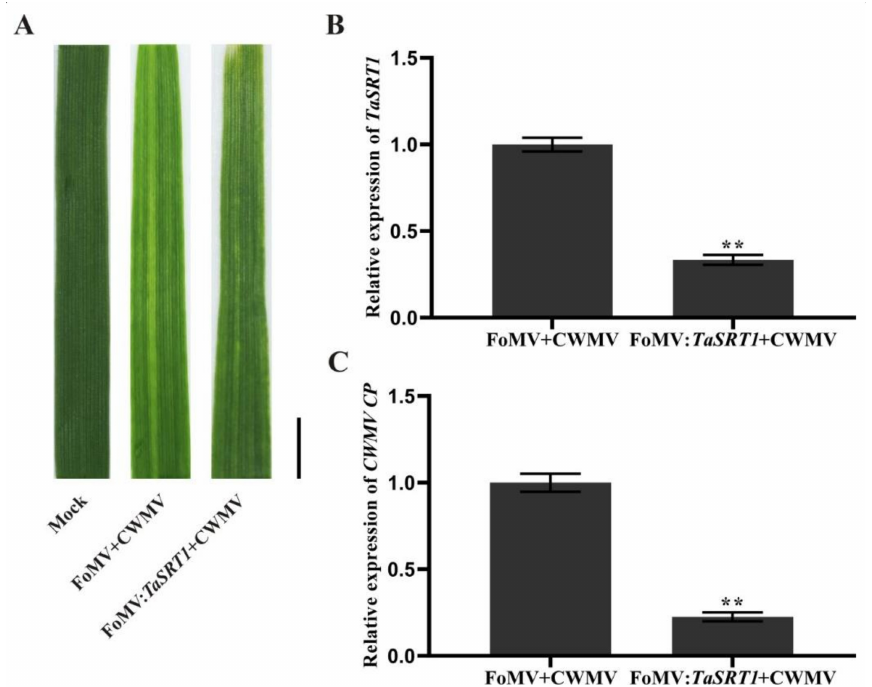
Figure 9. Silencing TaSRT1 by Foxtail mosaic virus (FoMV)-based virus-induced gene silencing (VIGS) significantly alleviated Chinese wheat mosaic virus (CWMV) infection in Triticum aestivum . ( A ) Phenotypes in newly formed leaves of the plants inoculated with phosphate buffer saline (PBS) as Mock, FoMV + CWMV, FoMV: TaSRT1 + CWMV, respectively. Photographs were taken at 14 d post-inoculation (dpi) with viruses. Bar = 1 cm. ( B ) Relative expression level of TaSRT1 was analyzed with FoMV: TaSRT1 + CWMV infected wheat plants by RT-qPCR. Total RNA from a FoMV + CWMV infected wheat plants was isolated used as a control. ( C ) Relative expression level of CWMV CP was analyzed in leaf 4 from TaSRT1 -silenced or non-silenced wheat plants. Each experiment was performed using three biological and each biological sample had three technical replicates. Statistical analyses were performed using the Student’s t -test. **, p <